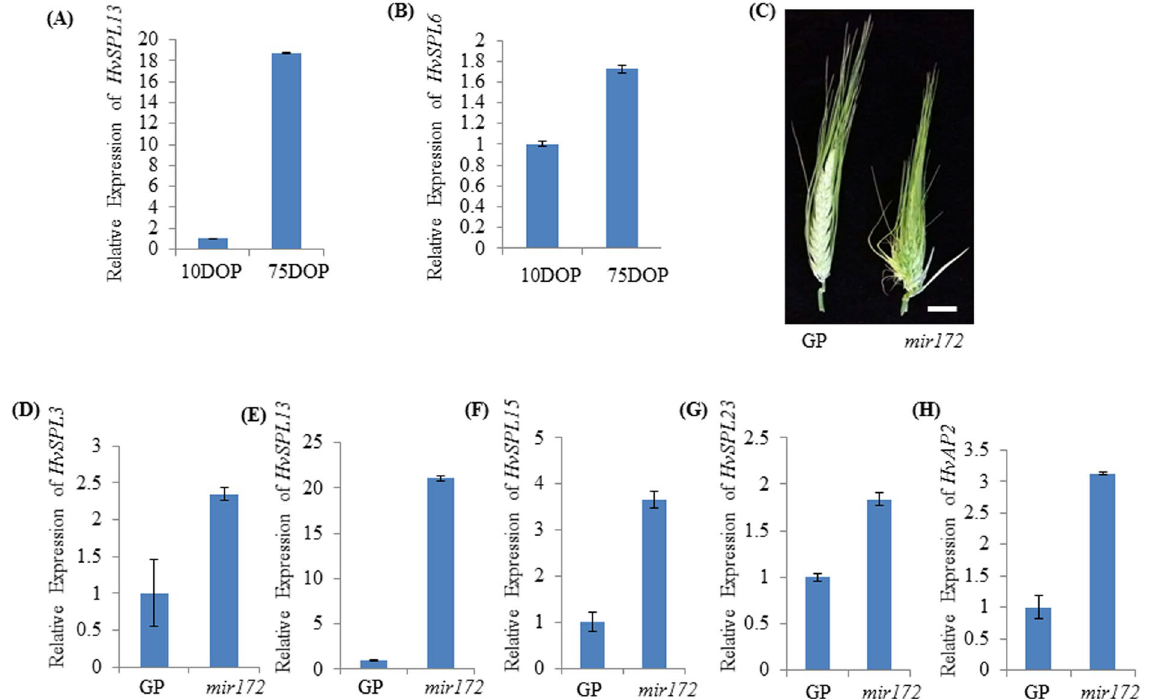
Figure 6. Expression of HvSPL genes during growth phase transition in barley. ( A ) Transcript abundance of HvSPL13 and ( B ) HvSPL6 at vegetative (10 days) and reproductive (75 days) phases. ( C ) Spike architecture of barley mir172 mutant and wild type GP. A single 3.6 kb Ds insertion in mir172 mutant was previously identified by Brown and Bregitzer, 2011. This mutant possesses abnormal spike at both apical region (glumes were changed to florets) and basal region (abnormal branched phenotype). ( D–H ) Expression of HvSPL3, 13, 15, 23 and AP2 genes in the spike of barley mir172 mutant and wild type GP. Transcript abundance was measured by